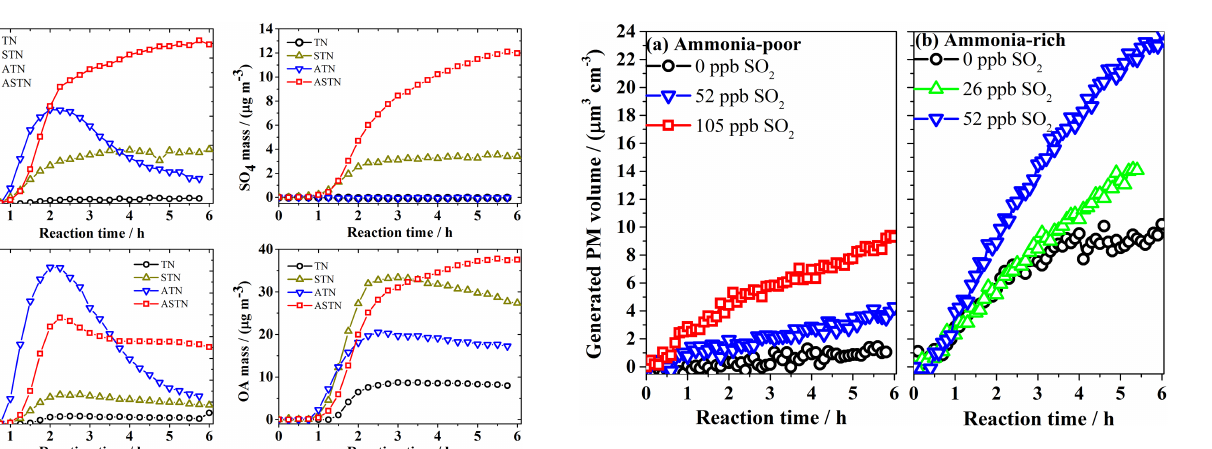
Figure 4. Secondary aerosol formation as a function of time with different concentrations of SO 2 in the photooxidation of toluene / NO x under NH 3 -poor (a) and NH 3 -rich (b) conditions. Ex- perimental details are listed in Table